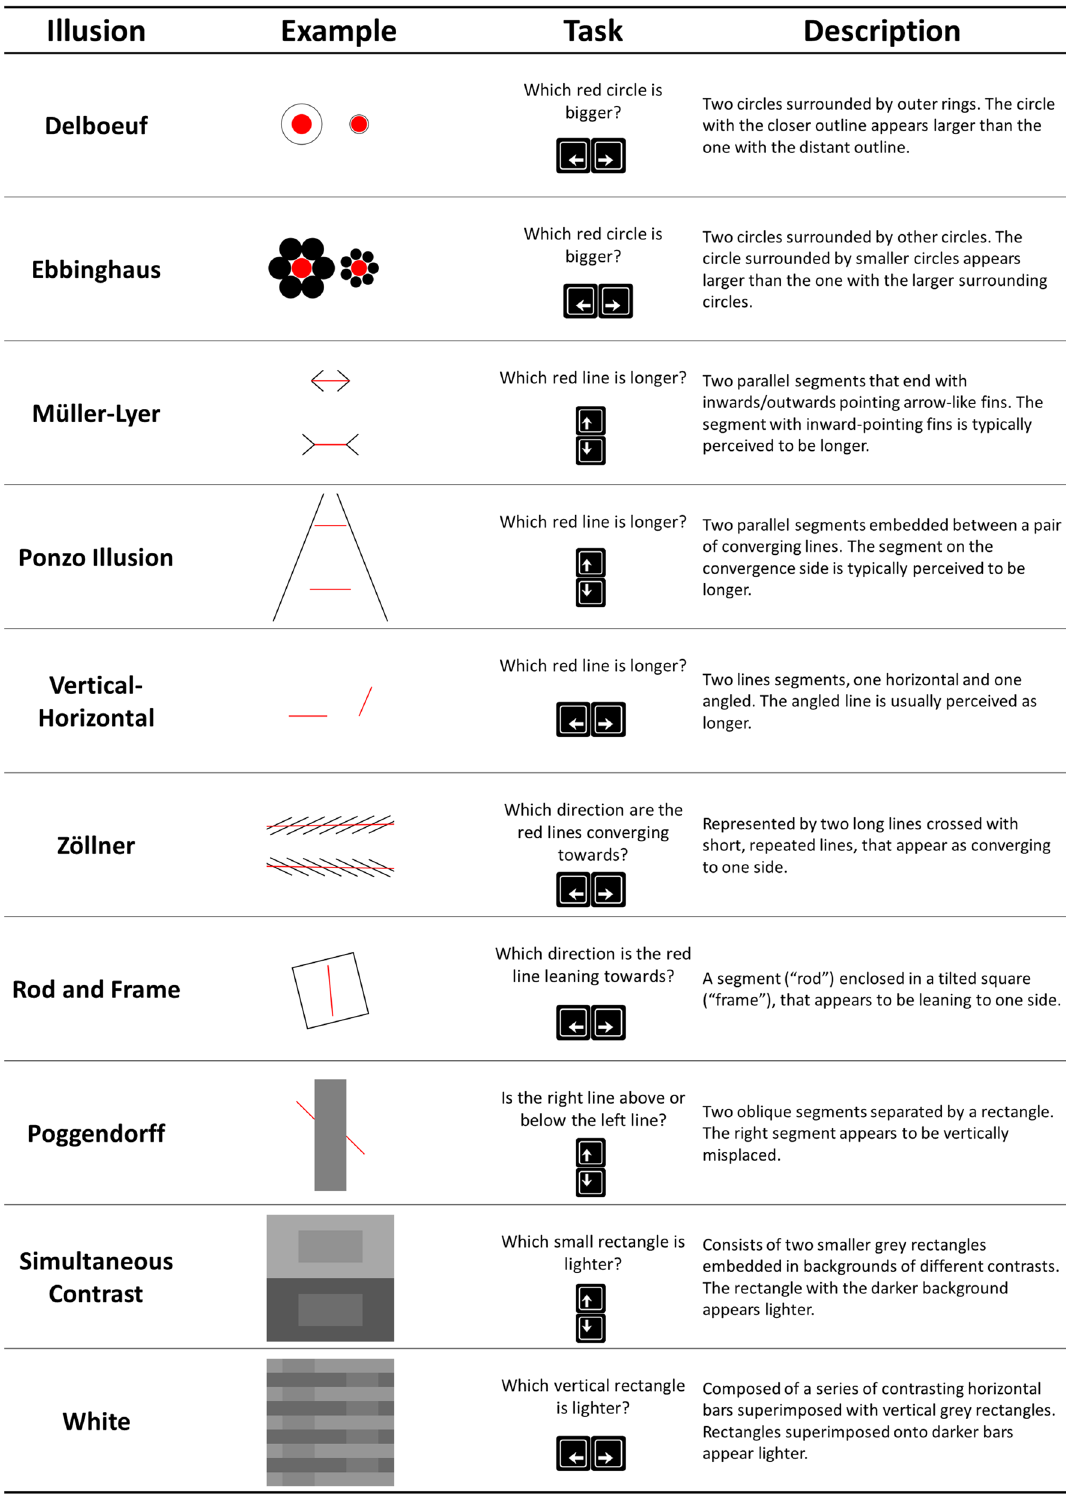
Figure 2. Ten different illusions were used as stimuli in a perceptual task, where participants had to answer as fast as possibly, without making errors, according to specific instructions. For each illusion type, two parameters were experimentally manipulated, (1) the task difficulty (e.g., how large was the difference between the bigger and the smaller red circles in the Delboeuf illusion), and (2) the illusion strength (e.g., the size of the black circles in the Ebbinghaus